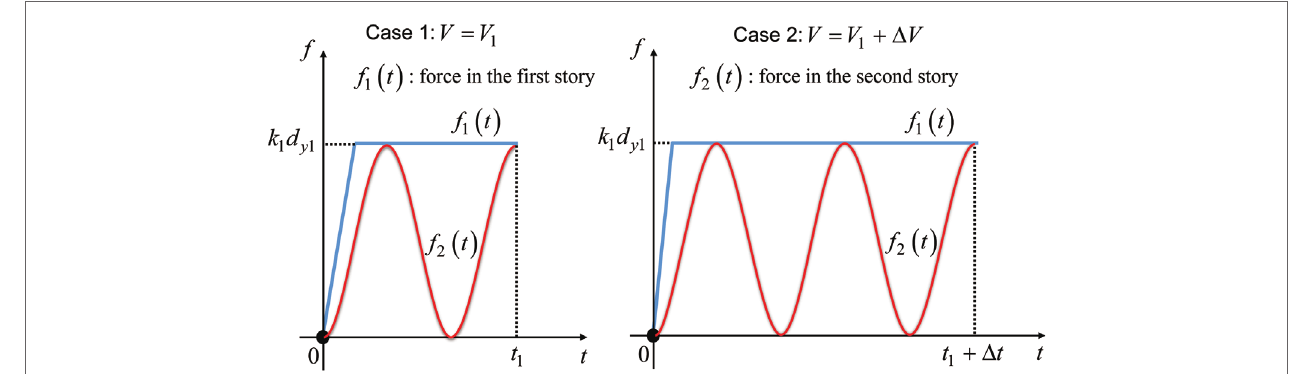
FigUre a4 | Time histories of the restoring forces in the first and second stories up to the phase